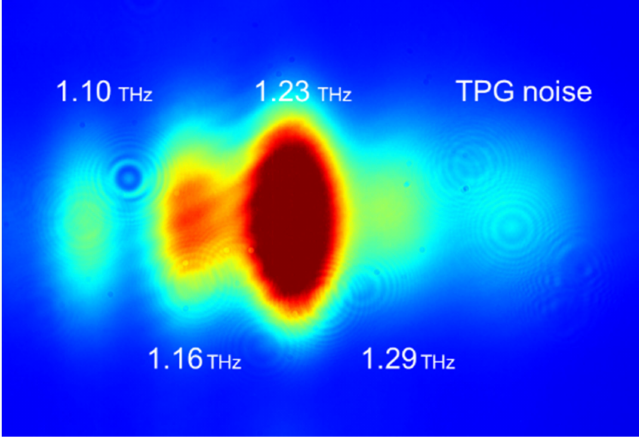
Figure 8. Simultaneous generation of four wavelengths from is-TPG using a multi-wavelength ECLD as an injection seeding source. Terahertz-wave parametric detection was used to upconvert the THz-waves to near-infrared